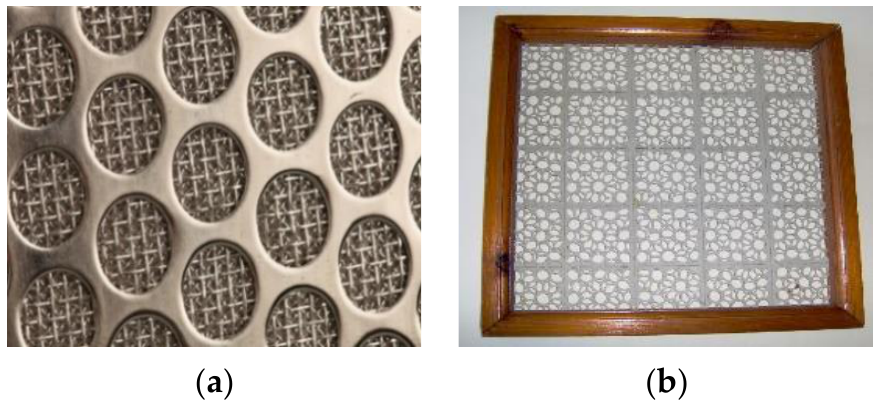
Figure 17. Mesh filter in a perforated steel frame ( a ) and wood frame ( b ) [44].